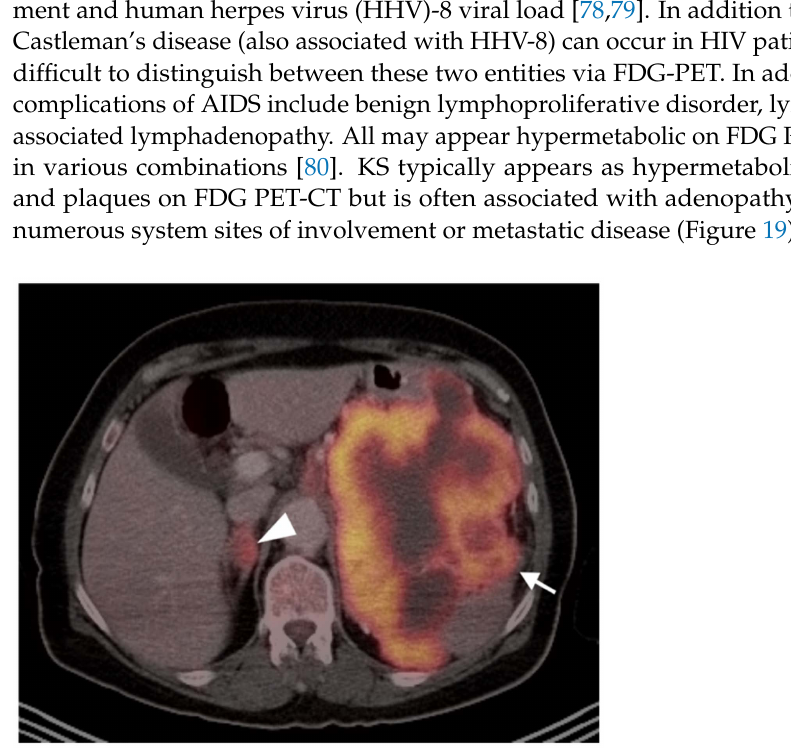
Figure 17. Angiosarcoma of the spleen. Axial FDG PET-CT of the upper abdomen shows an intensely hypermetabolic splenic tumor (white arrow) with scattered areas of necrosis. A hypermetabolic right adrenal metastasis is also present (white